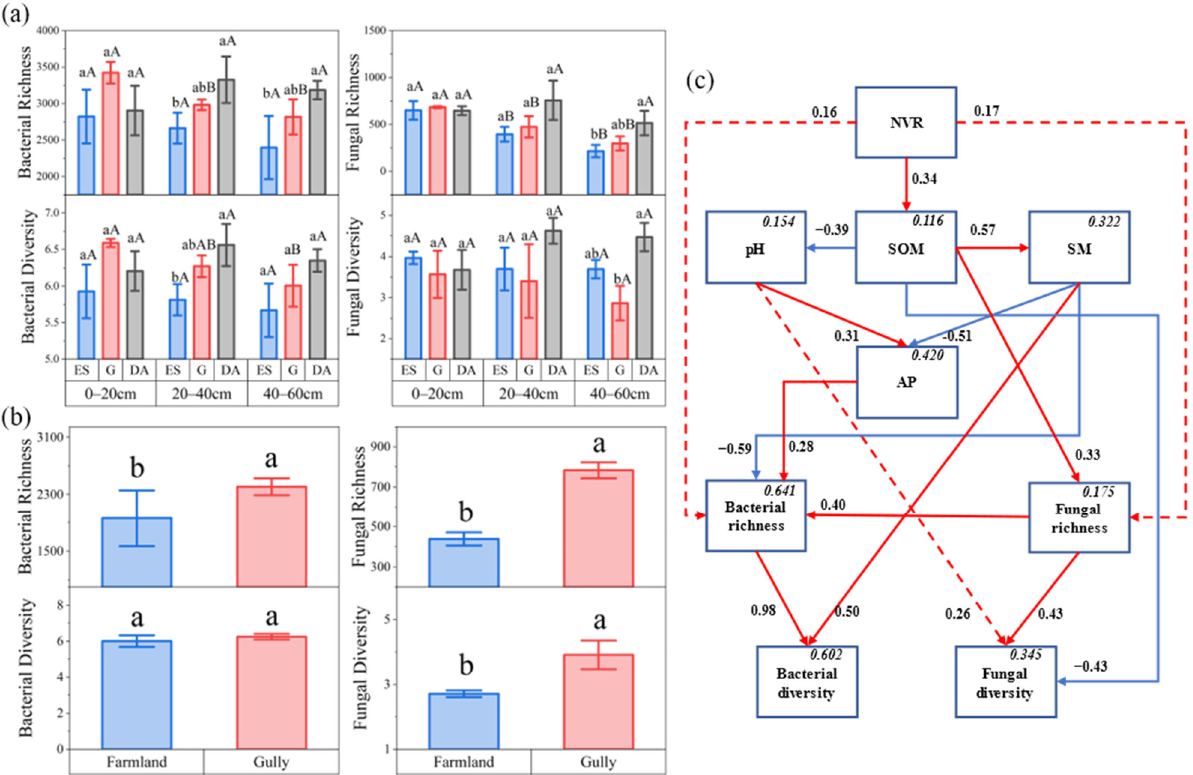
Figure 1. Alpha diversity of soil bacterial and fungal in farmland (FL), gully (GL) and deposition area (DA), and their response to the vegetation recovery and soil physicochemical properties. ( a , b ) are bacterial and fungal α diversity in the Guangrong site and Yanmagou site. Error bars are twice the standard error of the mean. Mean values with the same lower-case letter were not a significant difference at p < 0.05 among farmland, gully, and deposition area in each soil depth respectively. Mean values with the same capital letter were not a significant difference at p < 0.05 among depths in each area respectively; ( c ) is an SEM analysis indicates the influence of natural vegetation restoration (NVR) and soil physicochemical properties on the bacterial and fungal alpha diversity in both two sites in 0–20 cm, 20–40 cm and 40–60 cm soil depth ( χ 2 = 17.32, df = 20, p = 0.63). The solid line represents the significant relationship, while the dotted line means a non-significant relationship. The blue lines mean a negative relationship, while the red lines mean a positive relationship. The numbers inside the boxes of endogenous variables were R 2 .